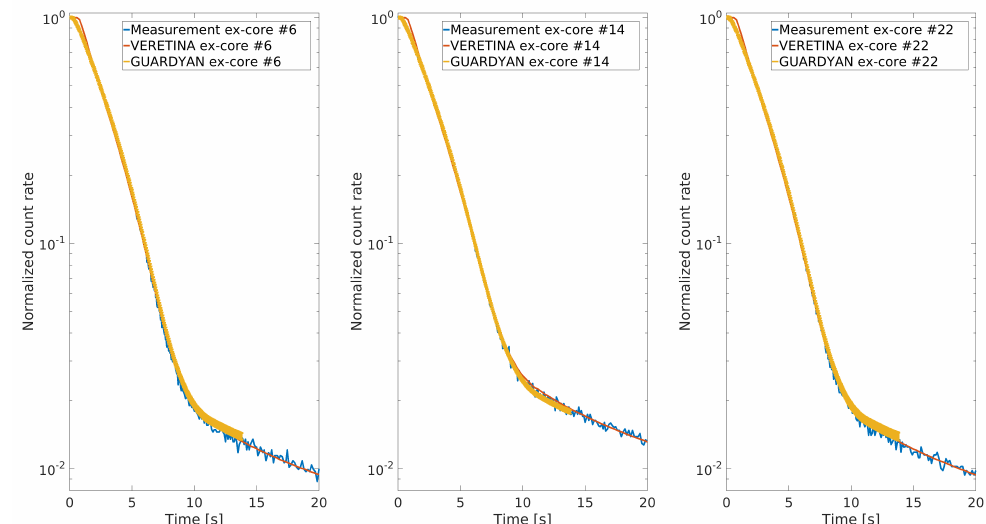
Figure 10. Comparison of ex-core detector signals to GUARDYAN and VERETINA results, logarith- mic scale.